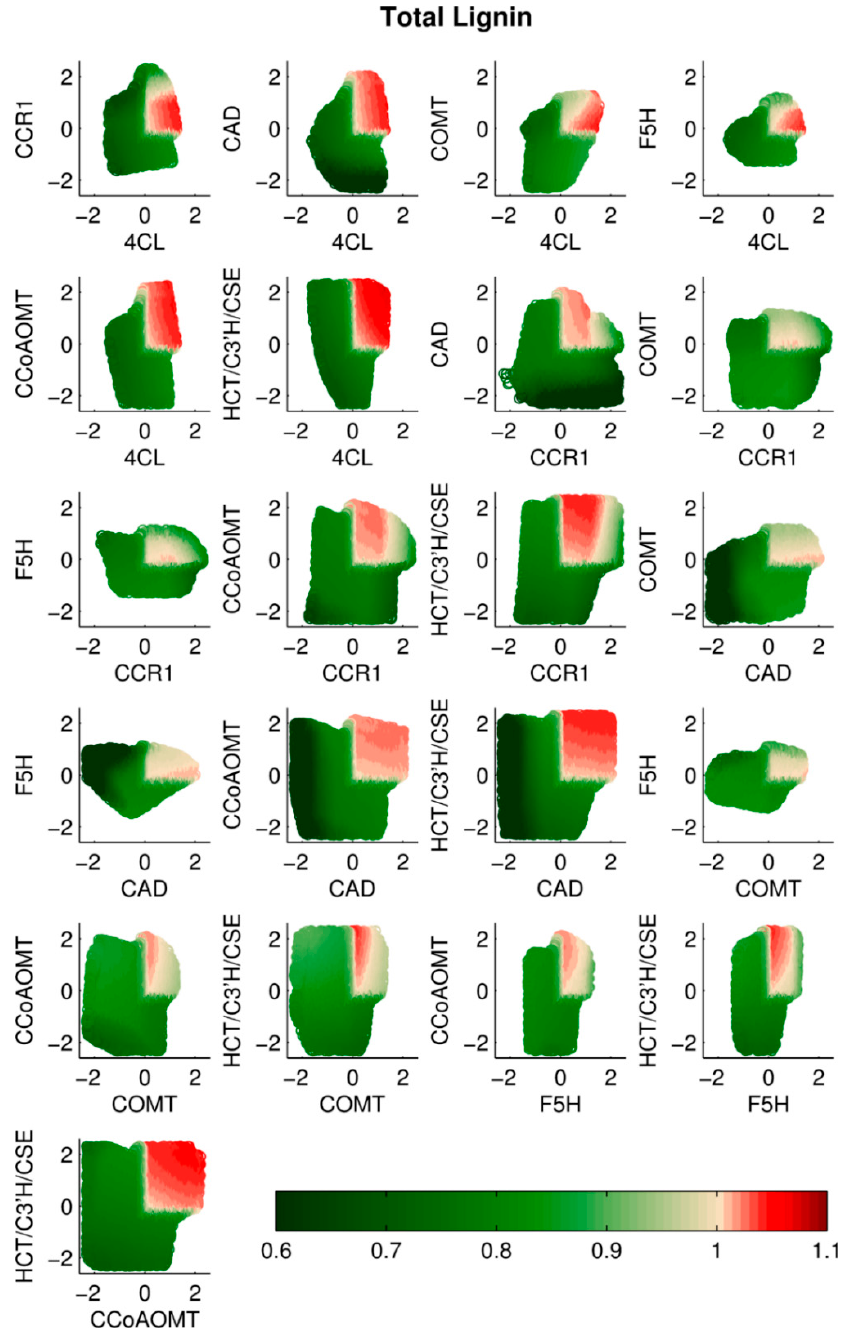
Figure 4. Total lignin in double enzyme perturbations. The color code is the same as in Figure 2. Pairs of CAD/4CL, CAD/CCR, and CAD/F5H are predicted as the most effective combinations; in particular, the pair of CAD/F5H shows strong synergism: an increase in F5H, combined with a small reduction in CAD, reduces total lignin dramatically. The nonlinear behavior of the pathway is evident in the dual-overexpression scenarios, especially in pairs, including CCR1, COMT, or F5H.